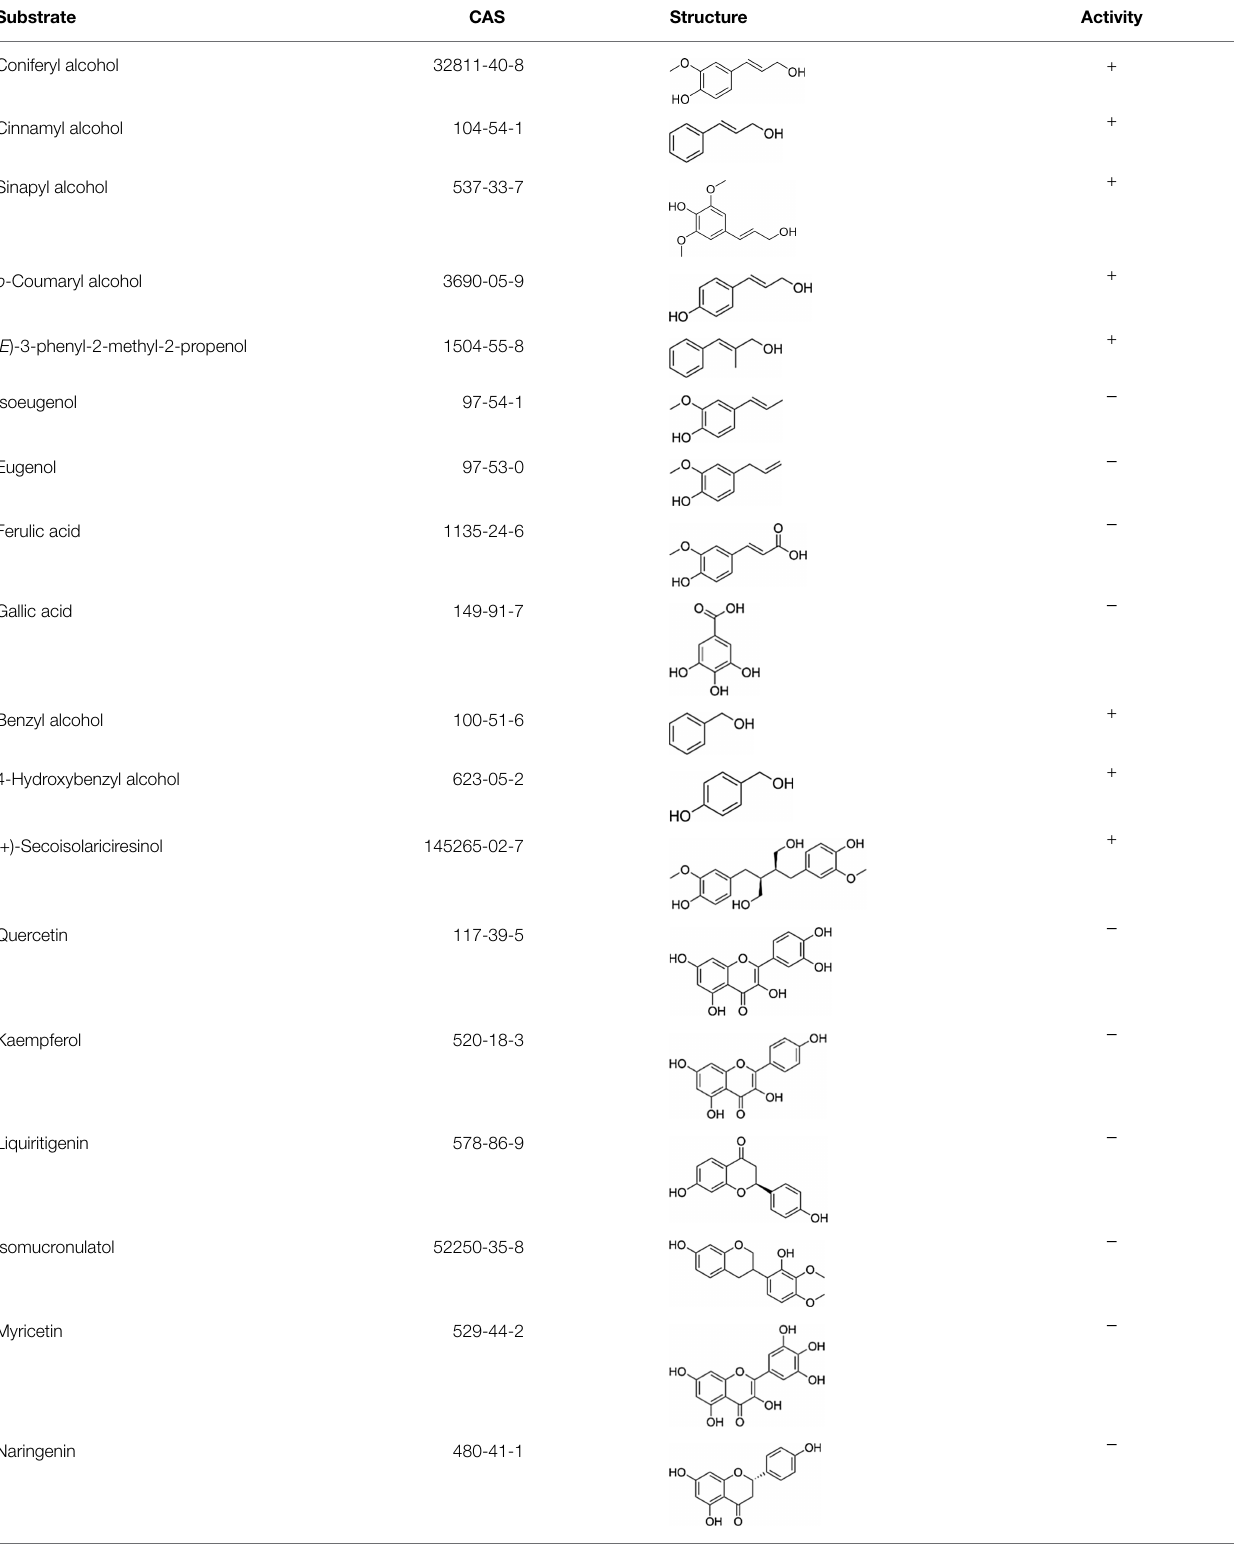
TABLE 2 | In vitro analyses of ScCFAT activities. CAS Structure